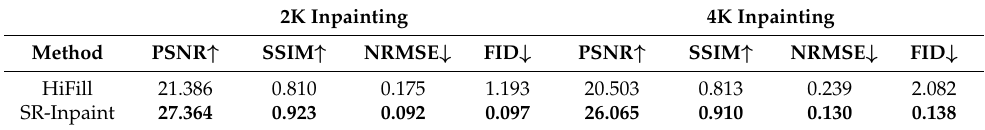
Table 1. Quantitative comparison of our model and the state-of-the-art